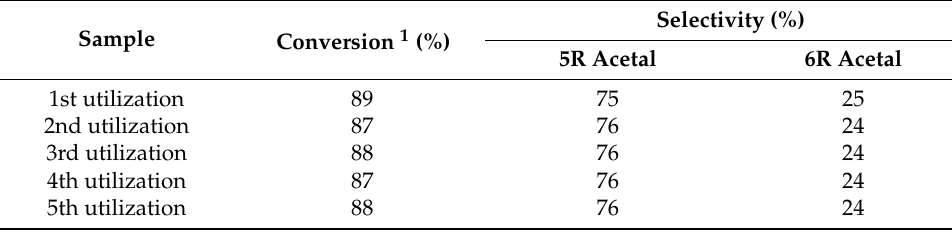
Table 3. Conversion of glycerol and selectivity to 5R acetal and 6R acetal.